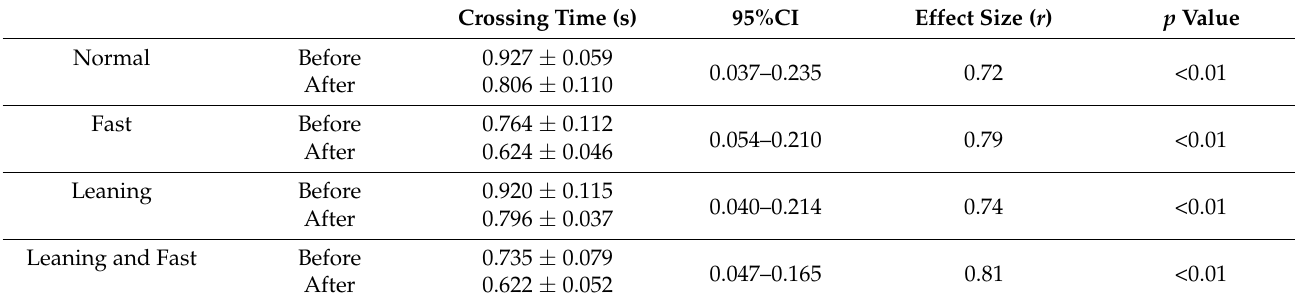
Table 6. Crossing time in the STG for heel in anterior obstacle crossing.